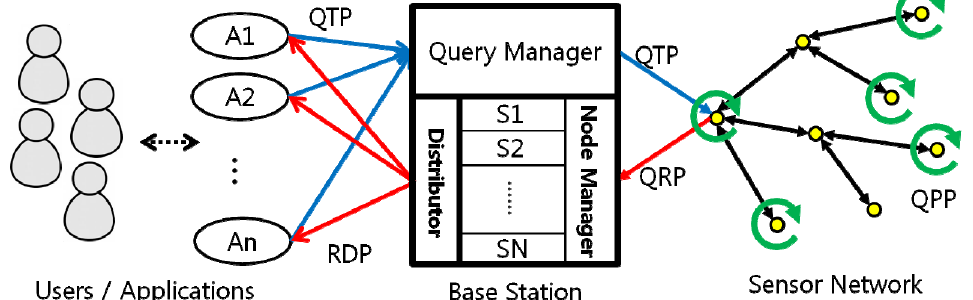
Figure 3. System architecture for the query management